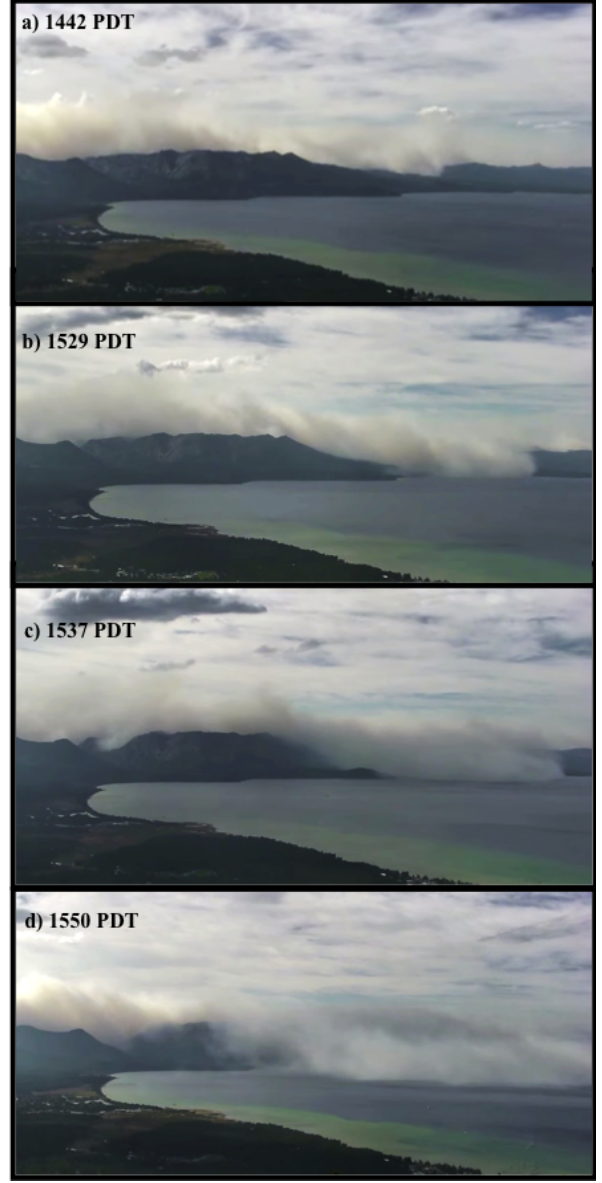
Figure 6. Photographic sequence of a smoke-filled density current originating from the King fire on 20 September 2014. The smoke is observed to spill across the crest of the Sierra Nevada and into the Tahoe Basin. The frames extracted from a time-lapse animation courtesy of the Nevada Seismic Laboratory. Time-lapse available at